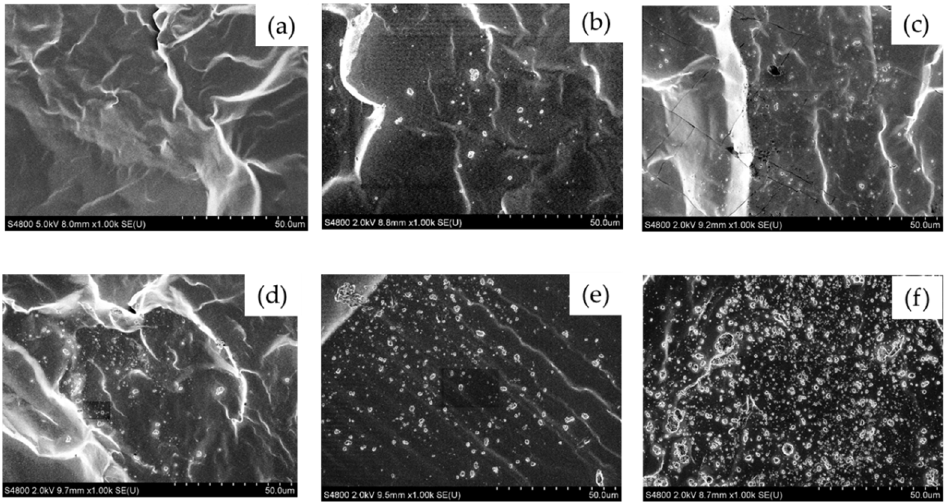
Figure 1. SEM image (×1.00k) of cross-section view of ( a ) neat PDMS; ( b ) PDMS with 1 wt.% SiO 2 ; ( c ) PDMS with 3 wt.% SiO 2 ; ( d ) PDMS with 5 wt.% SiO 2 ; ( e ) PDMS with 7 wt.% SiO 2 ; and ( f ) PDMS with 10 wt.% SiO 2 .